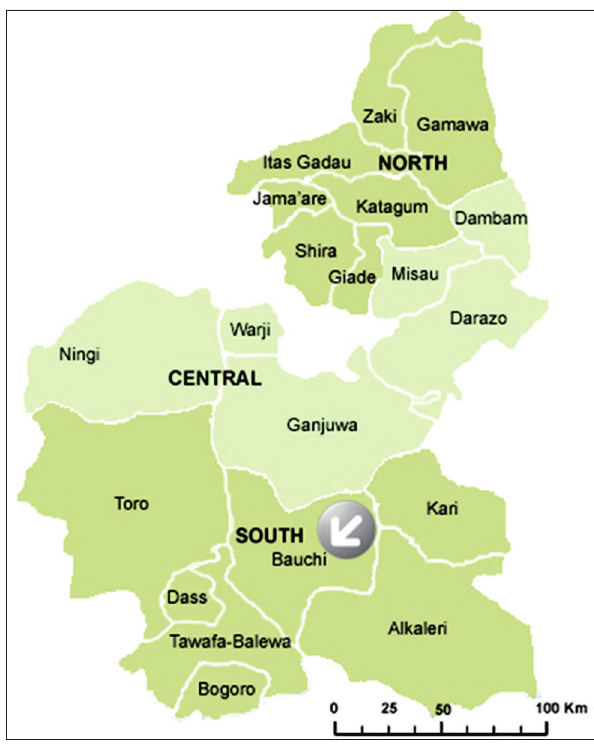
Figure-1: Map of Bauchi State with arrow indicating Bauchi Local Government Area (sourced from Google maps, Accessed on March 26,